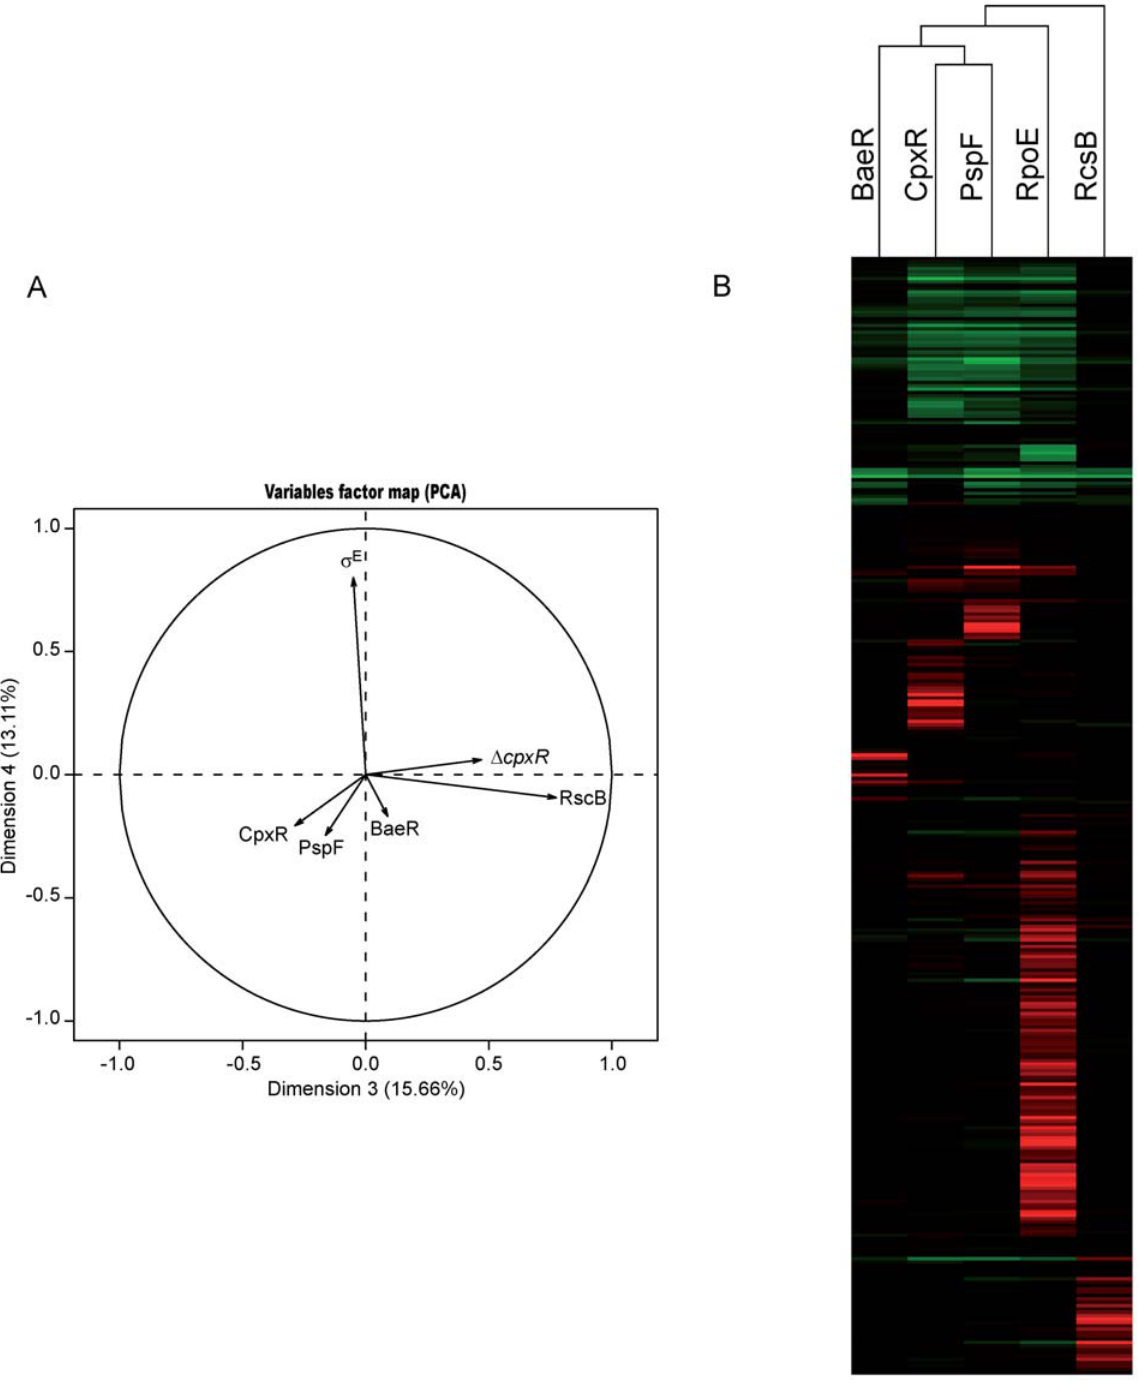
Figure 1. Transcriptome parallel analysis. (A) Correlation circle of the principal component analysis. Arrows indicate the different conditions. Principal componentaxes3and4arepresented.(B)Hierarchicalclusteringofgenesfoundtobesignificantlyregulatedinalltheconditionsstudiedbymicro-arrays.Bars in red and green indicate genes that are up- and down-regulated, respectively. Color intensities are proportional to the variation of expression.